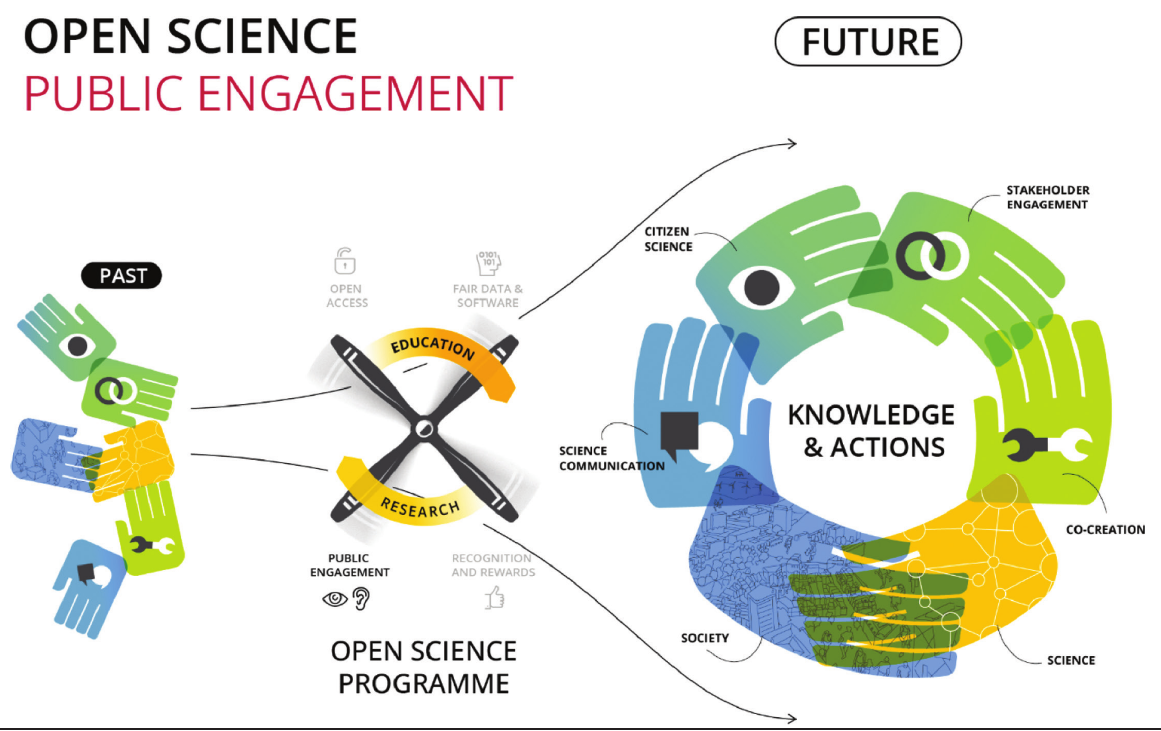
Figure 2. Conversation starter on public engagement and open science at Utrecht University (Source: Utrecht University,